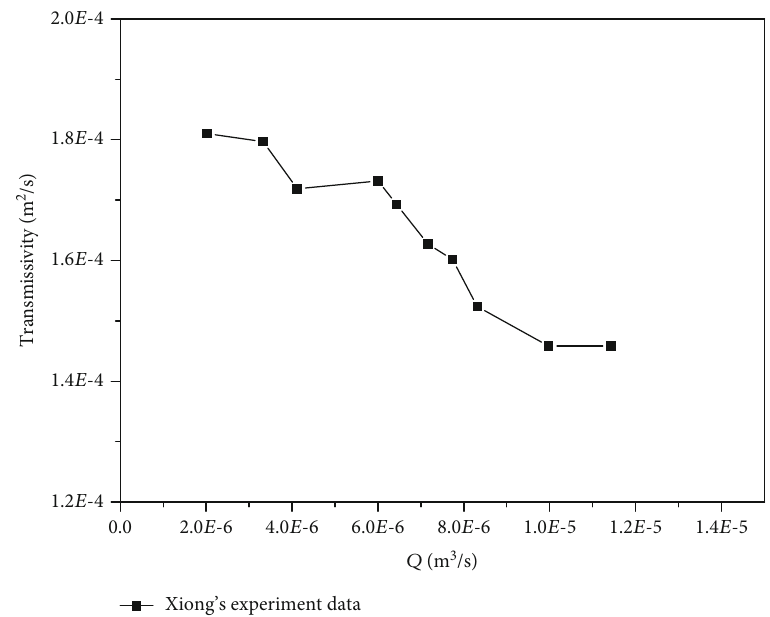
Figure 12: Transmissivity varies with fl ow rate with Xiong ’ s experiment data [1].